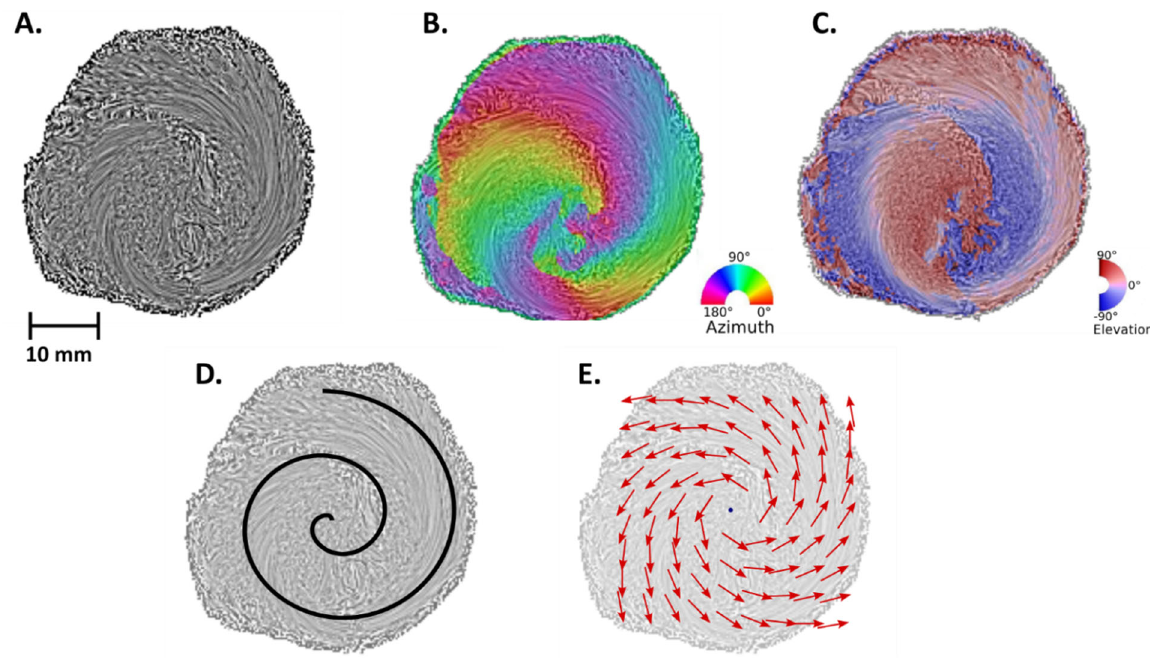
Figure 4. Left ventricular apex and +1 disclination. Apical sections of a perinatal heart (29 gestational weeks). The LV vortex (“+1 disclination”) is observed in the LIC map ( A ), in the azimuth map ( B ), and in the elevation map ( C ). The spiral ( D ) and the vector field ( E ) are superimposed at A, in order to help the reader to visualize the “+1 disclination”.